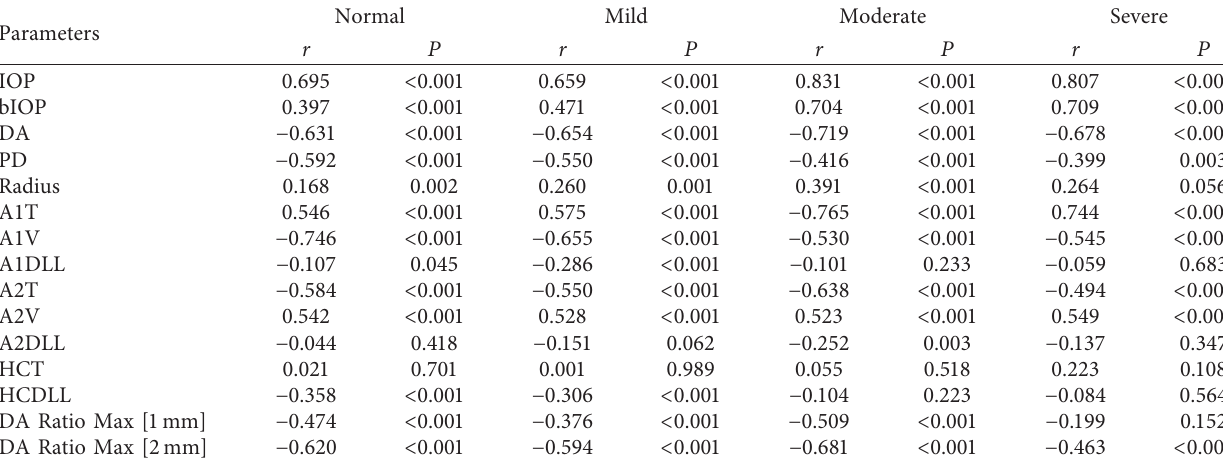
Table 2: Association between SP-A1 and Corvis ST parameters.